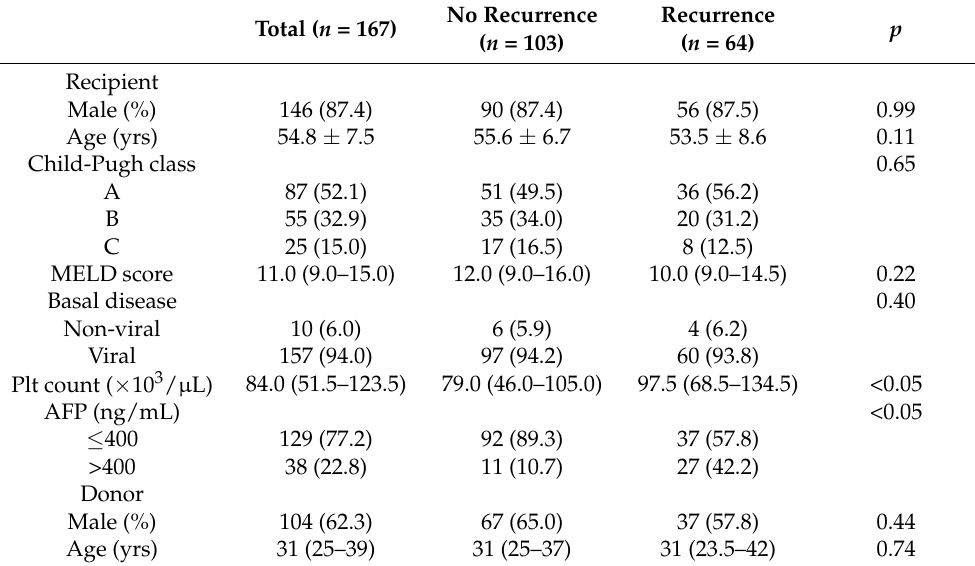
Table 4. Comparisons of the pretransplant characteristics in BM patients according to HCC recurrence within 5 years.